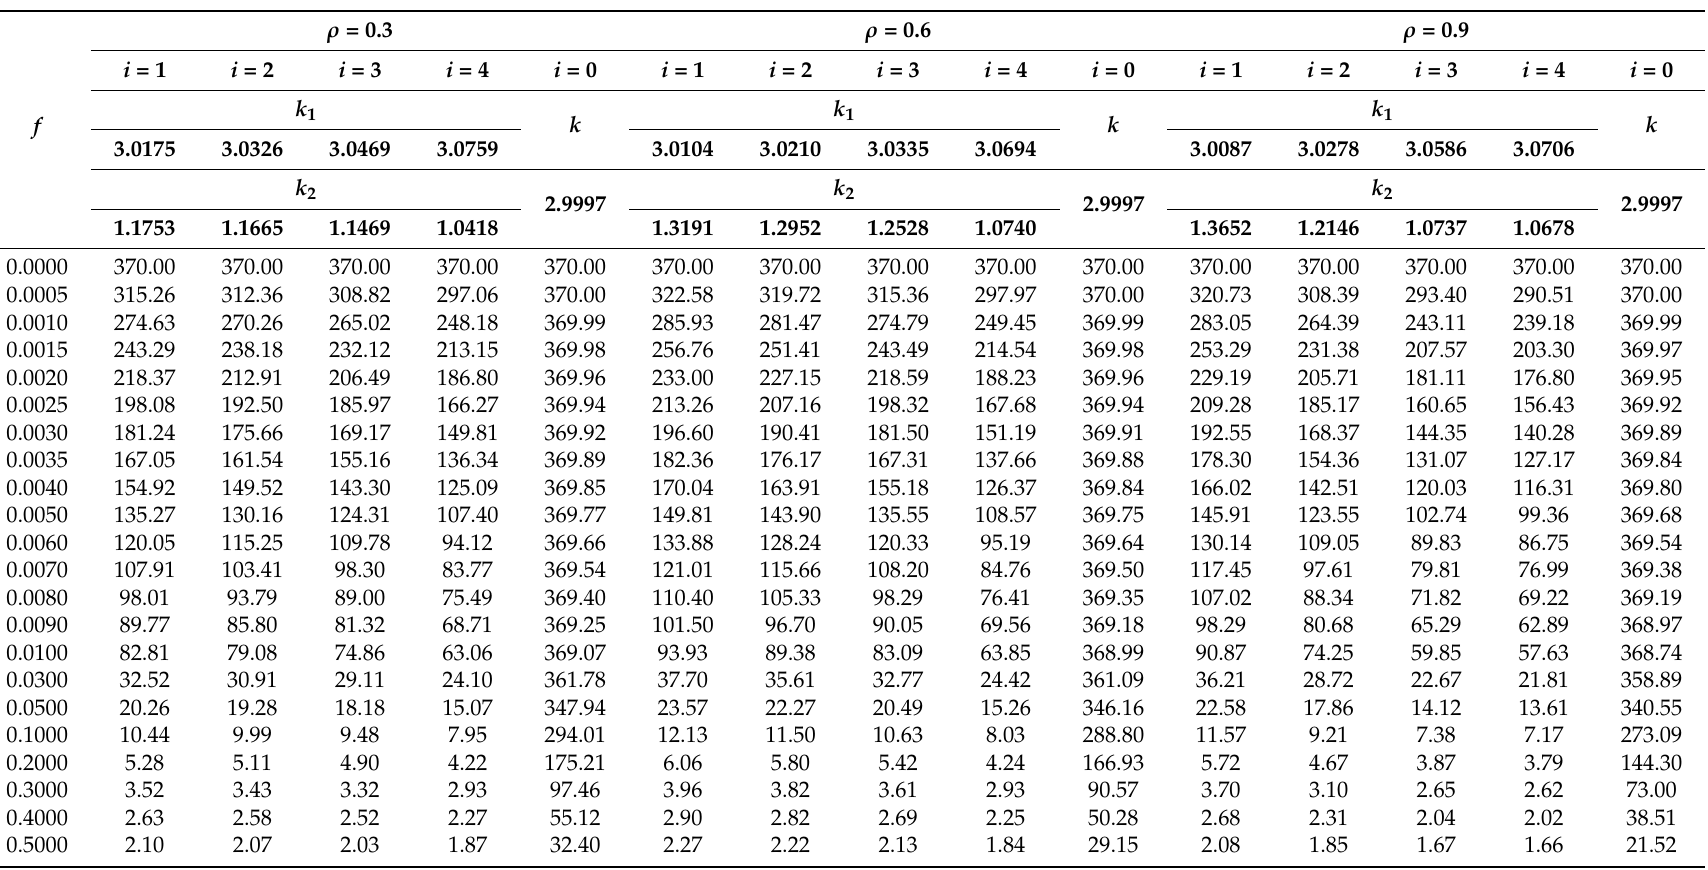
Table 4. The ARL analysis for 370 with n =